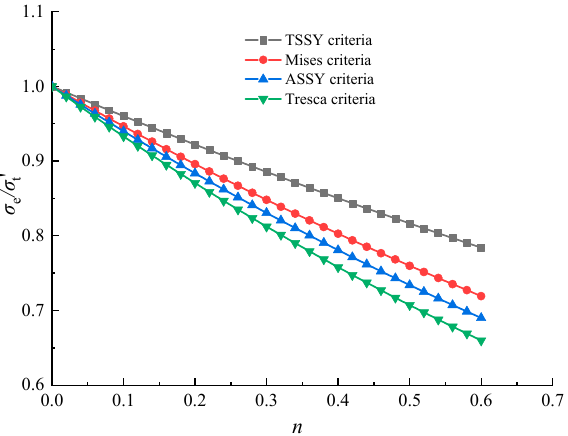
Figure 22. Variation of equivalent stress with strain hardening exponent n .